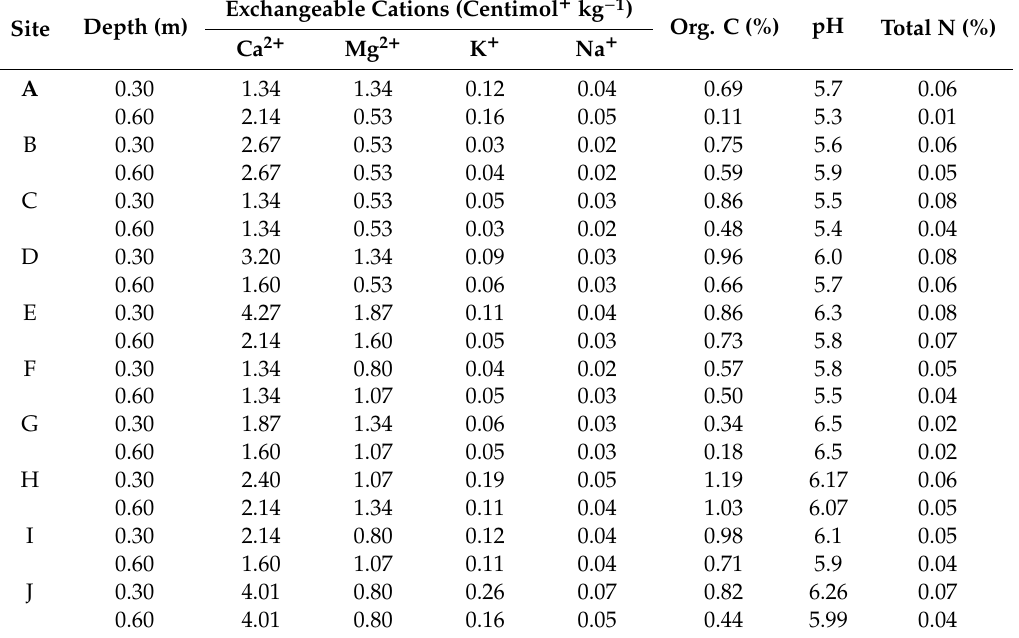
Table 3. Soil physical and chemical properties of studied farmers’ fields.